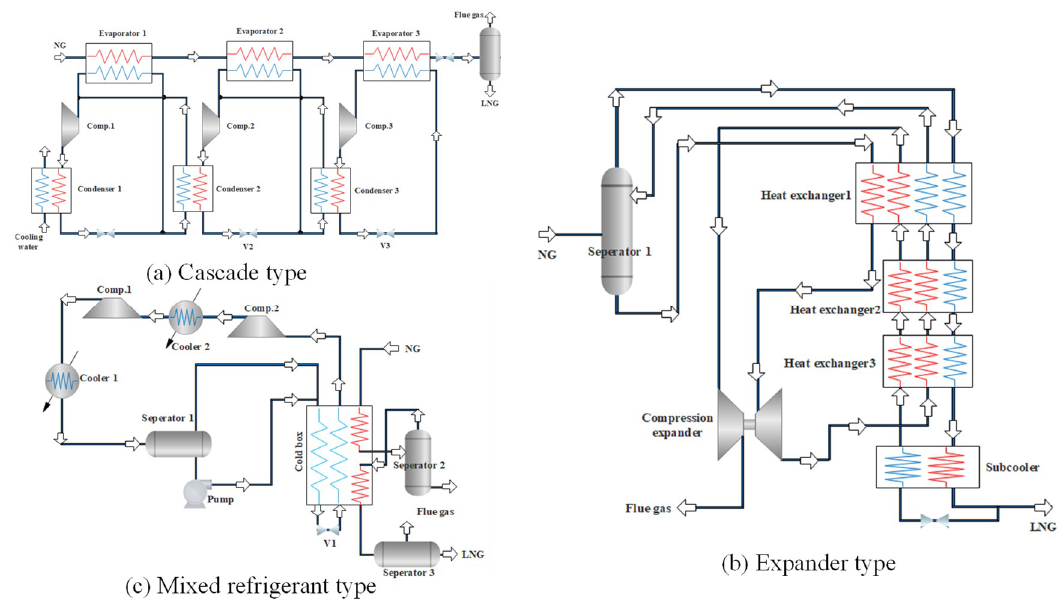
Figure 1. Schematic diagrams of three natural gas (NG) liquefaction processes. ( a ) Cascade type; ( b ) expander type; ( c ) mixed refrigerant type.